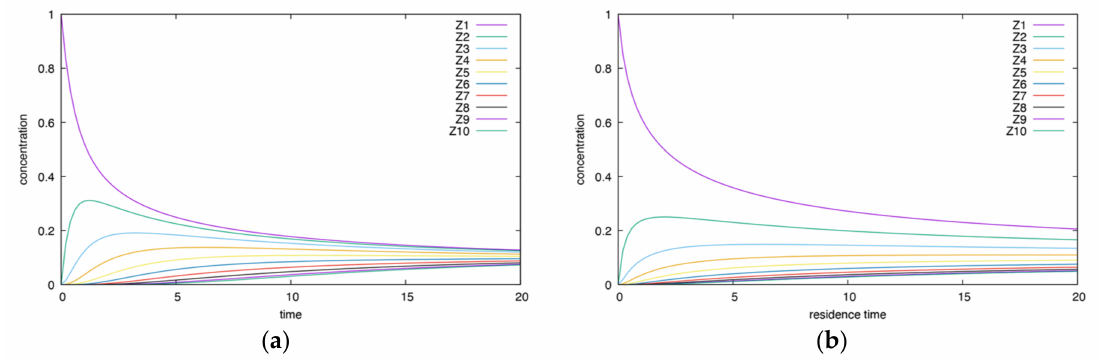
Figure A1. Evolutions in a BR ( a ) and in a CSTR ( b ) of the acyclic reversible mechanism, N =